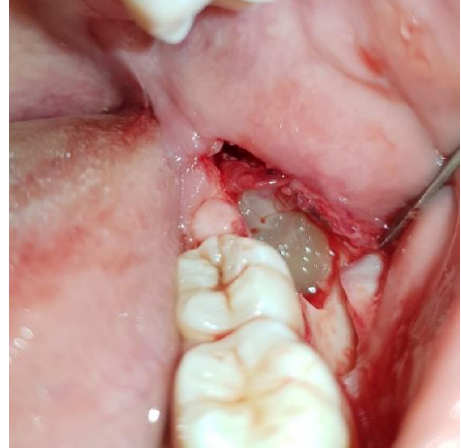
normal saline, place the PRF gently inside the socket, then suturing the flap (Fig. 3). The time to the end of suturing for each surgery.